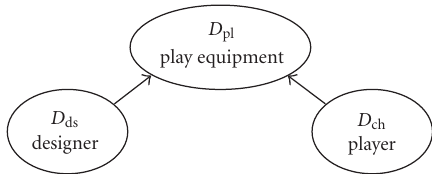
Figure 5: A slide derived from the design model using channel